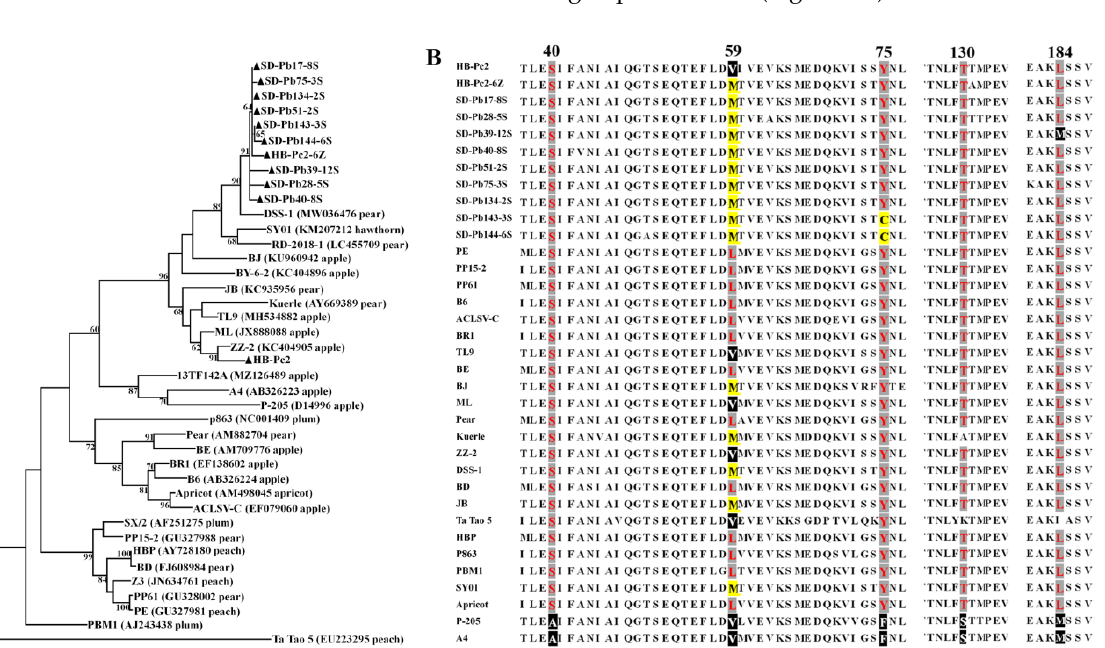
9 of 16 Figure 2. Unrooted maximum-likelihood (ML) phylogenetic trees generated from the nucleotide sequences of CP ( A ) and MP ( B ) genes of apple stem grooving virus (ASGV). The reported sequences